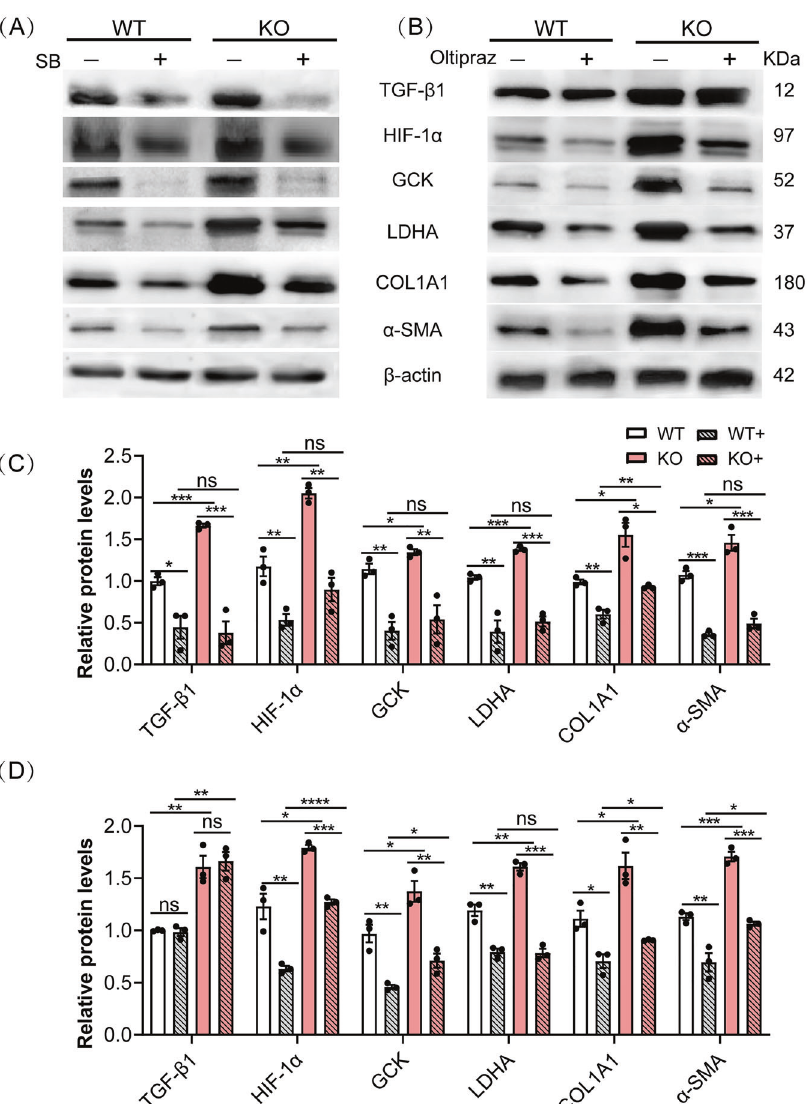
Fig. 5 Mybpc3 de fi ciency promoted HIF-1 α expression in fi broblasts. A , C Western blot analysis of HIF-1 α and the related signaling molecules in WT and MYBPC3-KO fi broblasts treated with or without SB-431542 (10 µM). B , D Western blot analysis of HIF-1 α and the related signaling molecules in WT and MYBPC3-KO fi broblasts treated with or without Oltipraz (10 µM). * P < 0.05; ** P < 0.01; *** P < 0.001; **** P < 0.0001; ns, not signi fi